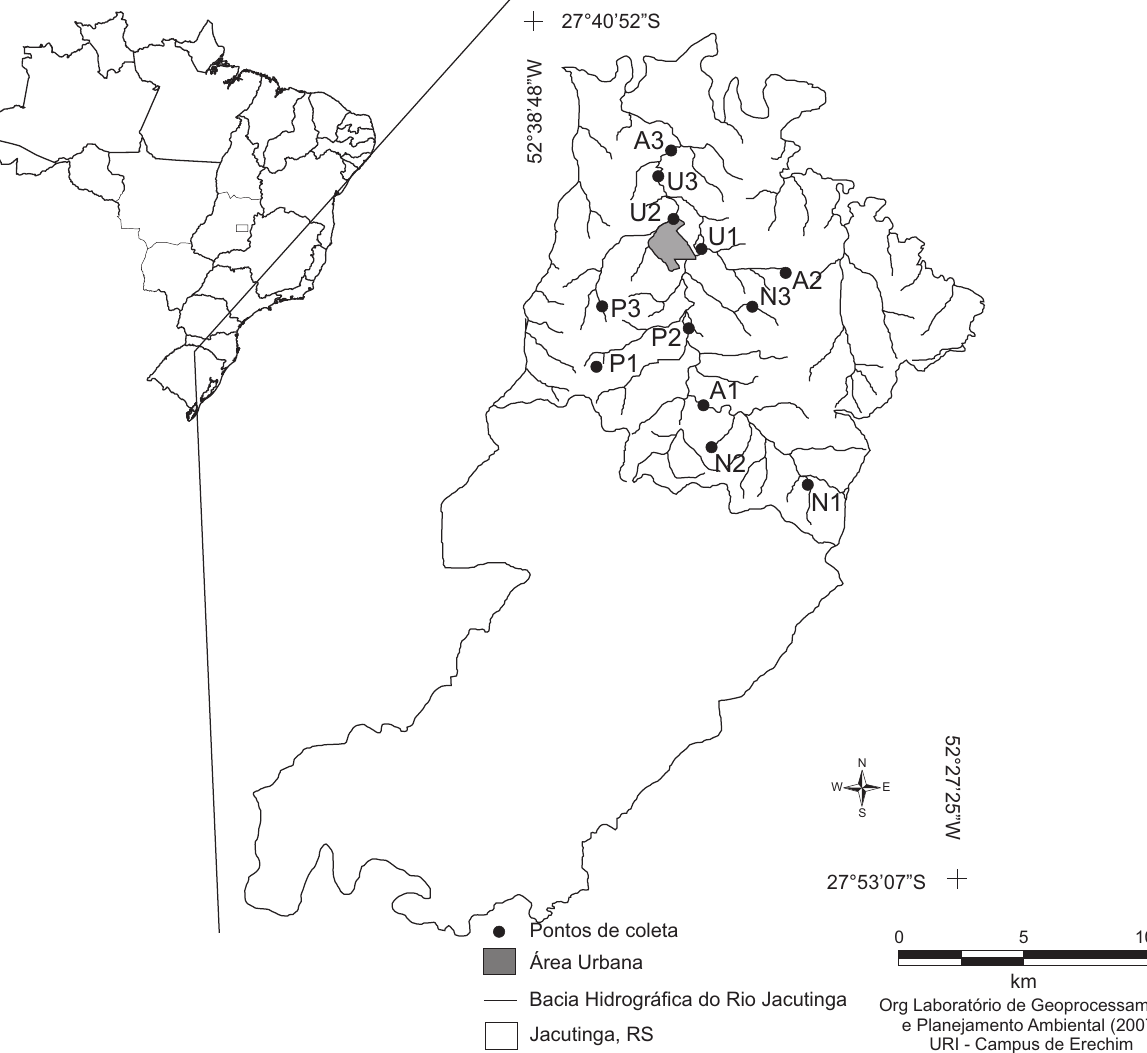
Figura 1. Localização da bacia hidrográfica do Rio Jacutinga e locais de coleta no município de Jacutinga, Rio Grande do